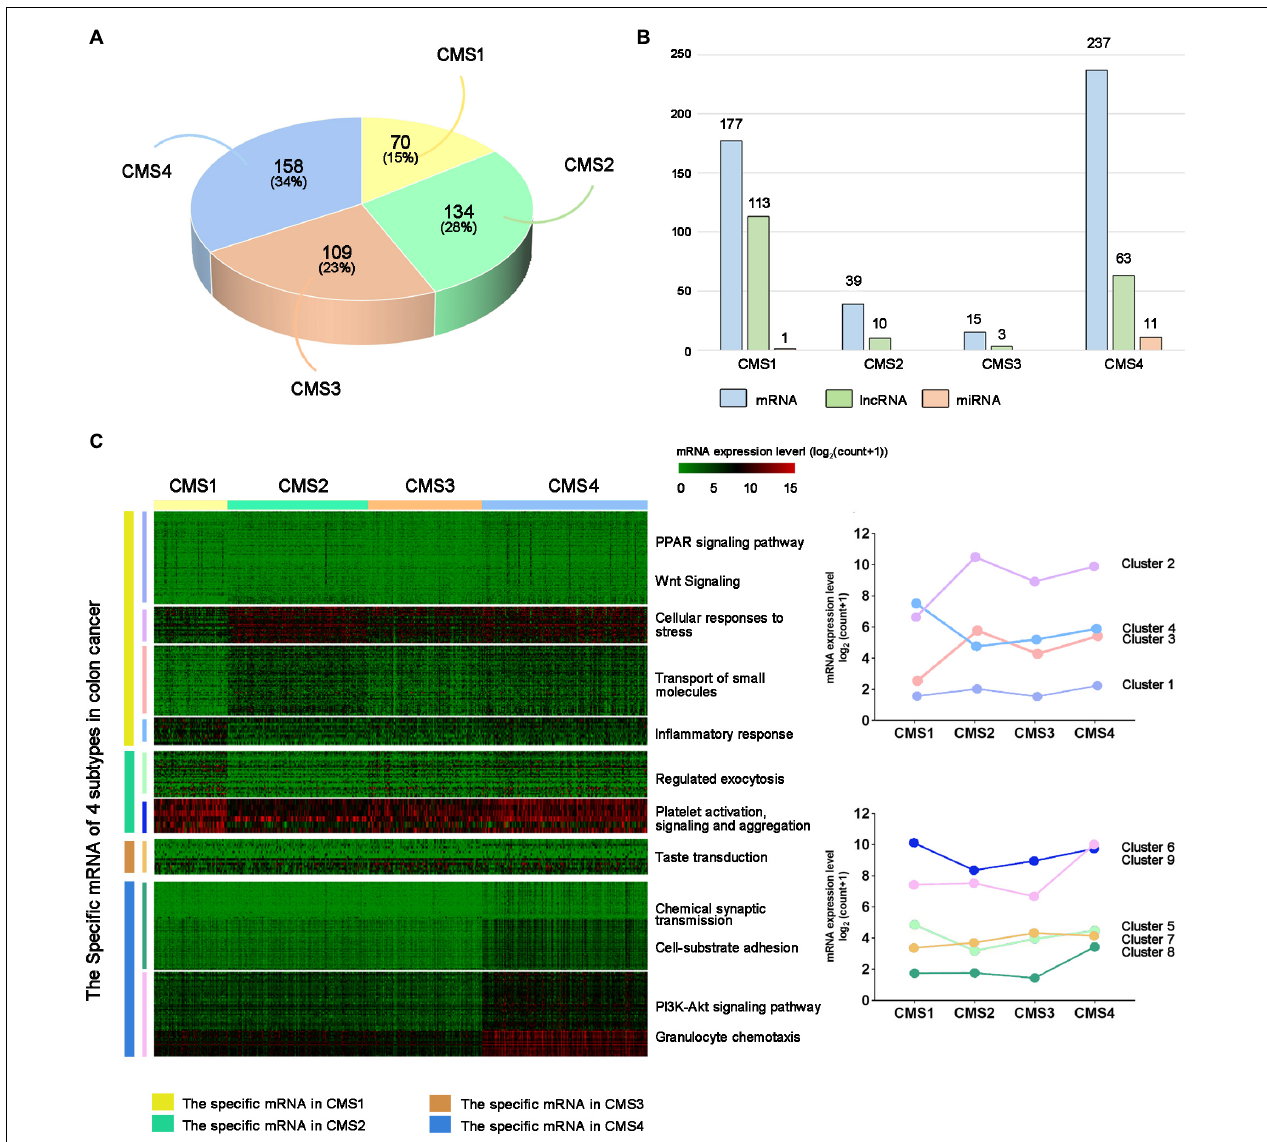
FIGURE 1 | Subtype-specific RNA analysis of colon cancer. (A) Statistical analysis of colon cancer samples from each subtype. (B) Number of subtype-specific RNAs identified in each subtype. (C) The left panel shows hierarchical clustering analysis and GO analysis of subtype-specific RNAs in each subtype. Red indicates a high expression level, and green indicates a low expression level. The right panel shows the average values of subtype-specific RNAs in different clusters of the four